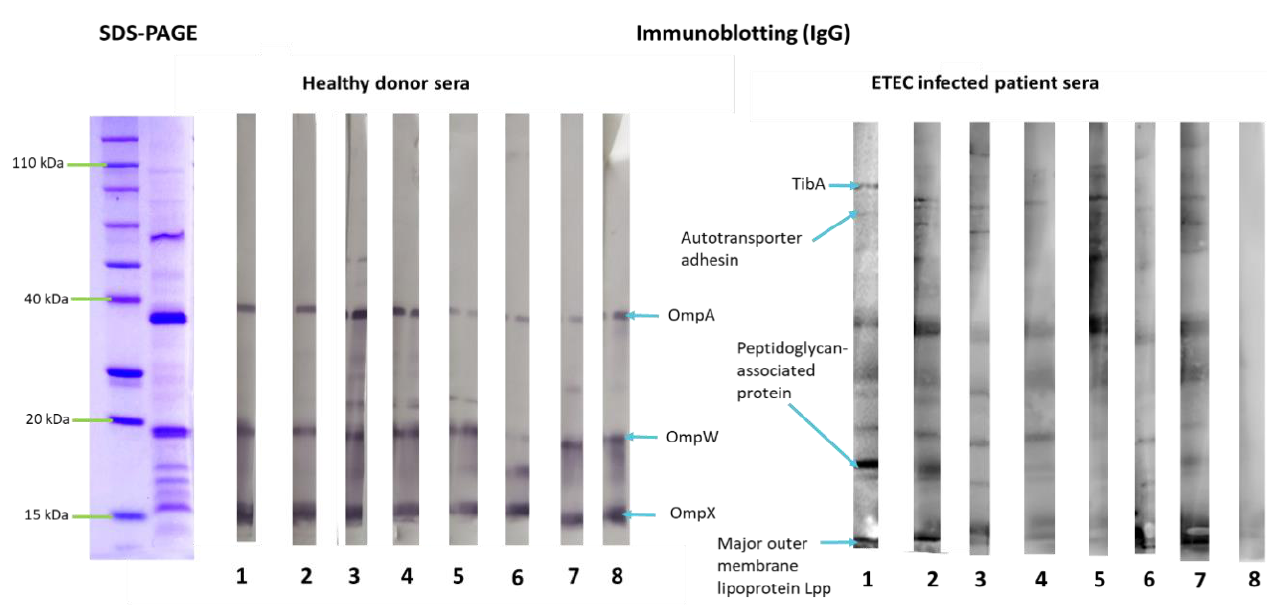
Figure 2. IgG reactivity with outer membrane vesicles (OMVs) isolated from two clinical Enterotoxigenic Escherichia coli (ETEC) isolates incubated with ETEC infected patient’s sera (n = 8) or healthy donor sera (n = 8). Protein-binding sites were blocked with 5% skimmed milk in PBS at room temperature overnight. After incubation with sera, the membranes were treated with peroxidase (PO)-conjugated secondary antibody GAHu/IgG (H+L), HRP conjugate (1:1000) for 60 min at room temperature. The antibody – antigen complexes were visualized by addition of a substrate/chromogen solution (H 2 O 2 /4-chloro-1-naphthol). Blue arrows indicate previously identified OMV proteins that were recognized by IgG antibodies.